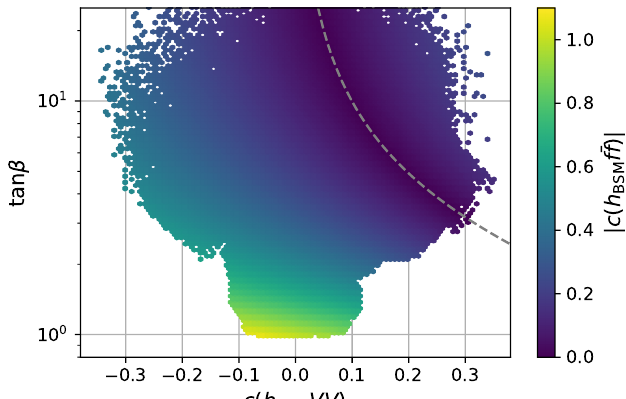
Figure 2. The allowed parameter region for the effective gauge coupling c ( h BSM V V ) of the non- h -even scalar h and tan β . The exact alignment limit for h 125 CP BSM c ( h BSM V V ) = 0 . The color code represents the SM-normalized fermion coupling of h BSM , which vanishes in the fermiophobic limit indicated by the dashed line. Parameter points where both m h ∈ [120 , 130] GeV are not shown to allow a clear distinction between h BSM and h 125 1 , 2